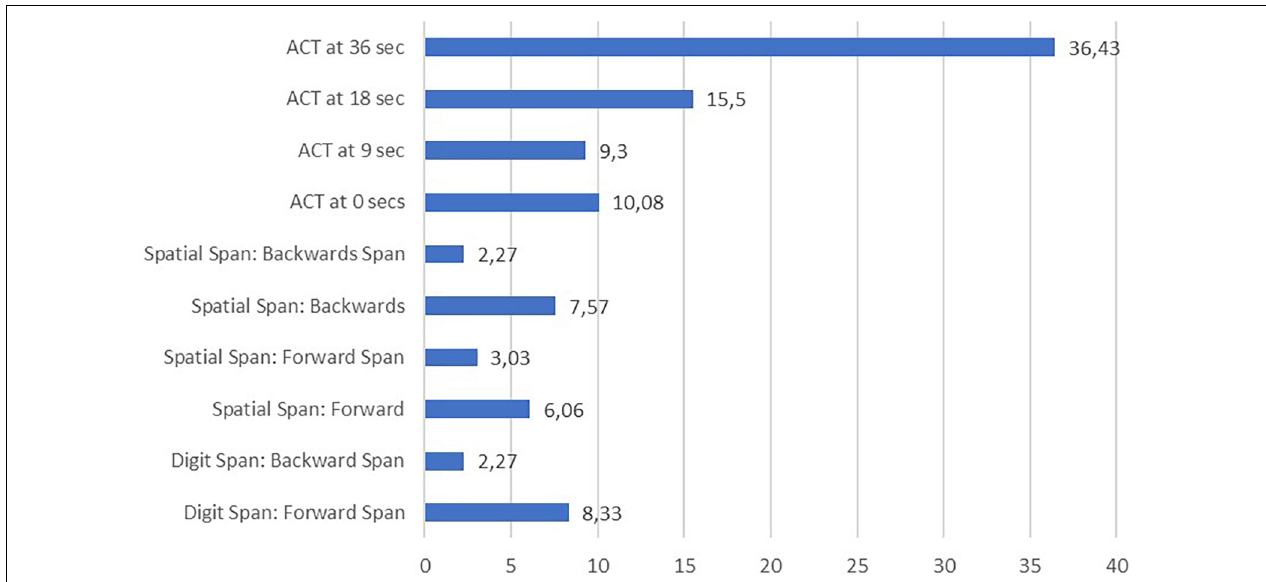
FIGURE 2 | Percentage of fibromyalgia patients with deficient performance in working memory measures based on normative data ( < 1.5 SD below normative mean).